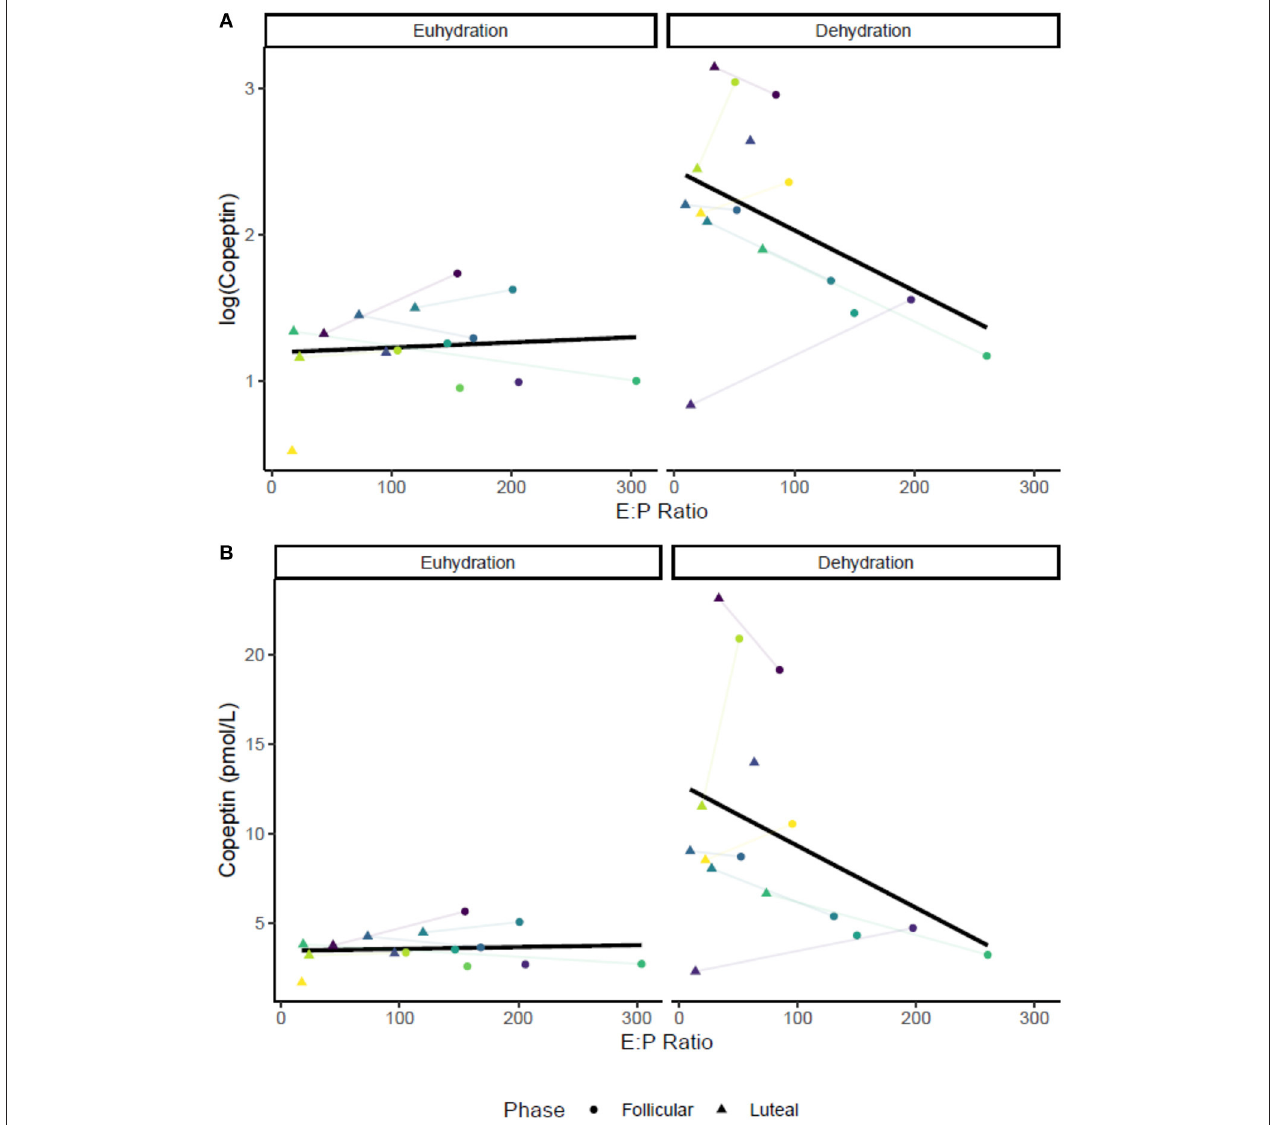
FIGURE 1 | Relationships between E:P [all • 10 3 ] and pre-exercise copeptin concentration in both conditions: euhydrated ( ad libitum fluid consumption for 24-h, USG ≤ 1.020, P > 0.05) and dehydrated (24-h fluid restriction, USG > 1.020, P = 0.054). Colored dots show individual data for in both trials (follicular and luteal). (A) shows log-transformed copeptin data, and (B) shows raw values. Colored dots show individual trials; lines between dots connect individual trials within